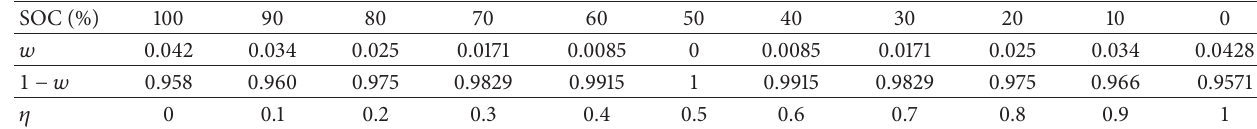
Table 1: Values of 𝑤 , ( 1 − 𝑤 ), and 𝜂 respective to the SOCs.